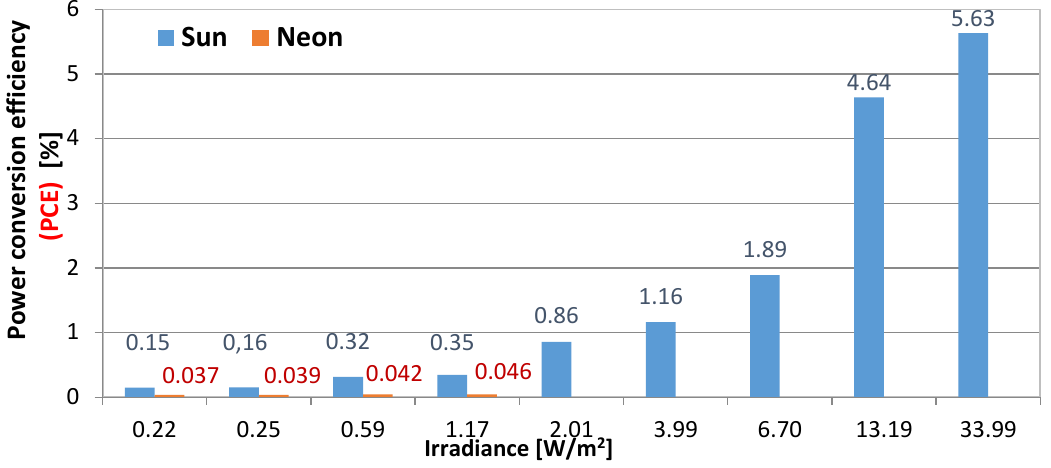
Figure 13. Histogram with reported the power conversion efficiency of employed flexible solar cells, as function of the irradiance level 1 , when exposed to the sunlight (blue bars) and Ne lamp (red bars). 1 Irradiance values calculated from the illuminance ones [lux] in Table 2, using distinct conversion coefficients [Wm −2 lux −1 ] for sunlight and Ne source (respectively 0.0079 and 0.0111), known the area of two Size 2 cells.